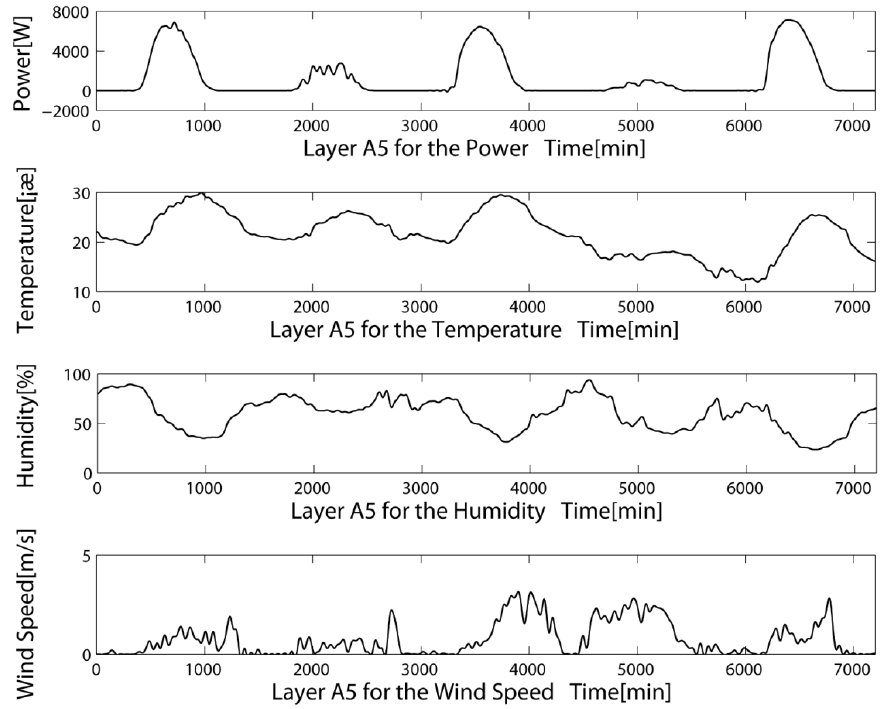
Figure 8. A5 layer comparison of different signals.